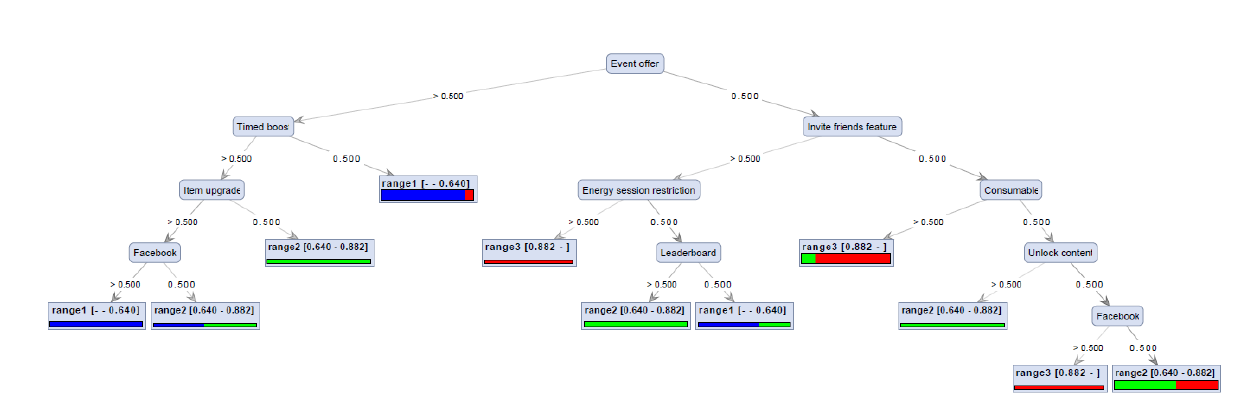
Fig. 7. Decision tree generated by Rapid Miner to Download